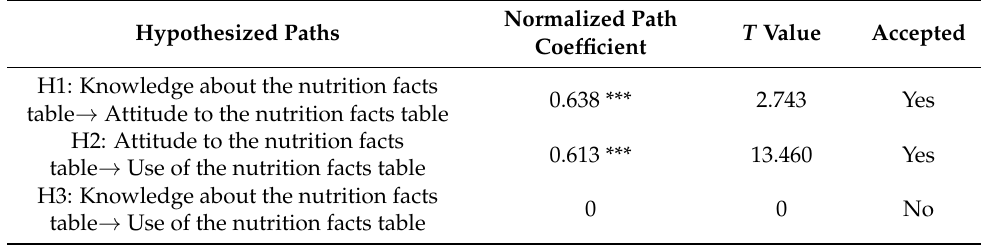
Table 7. Test results of the